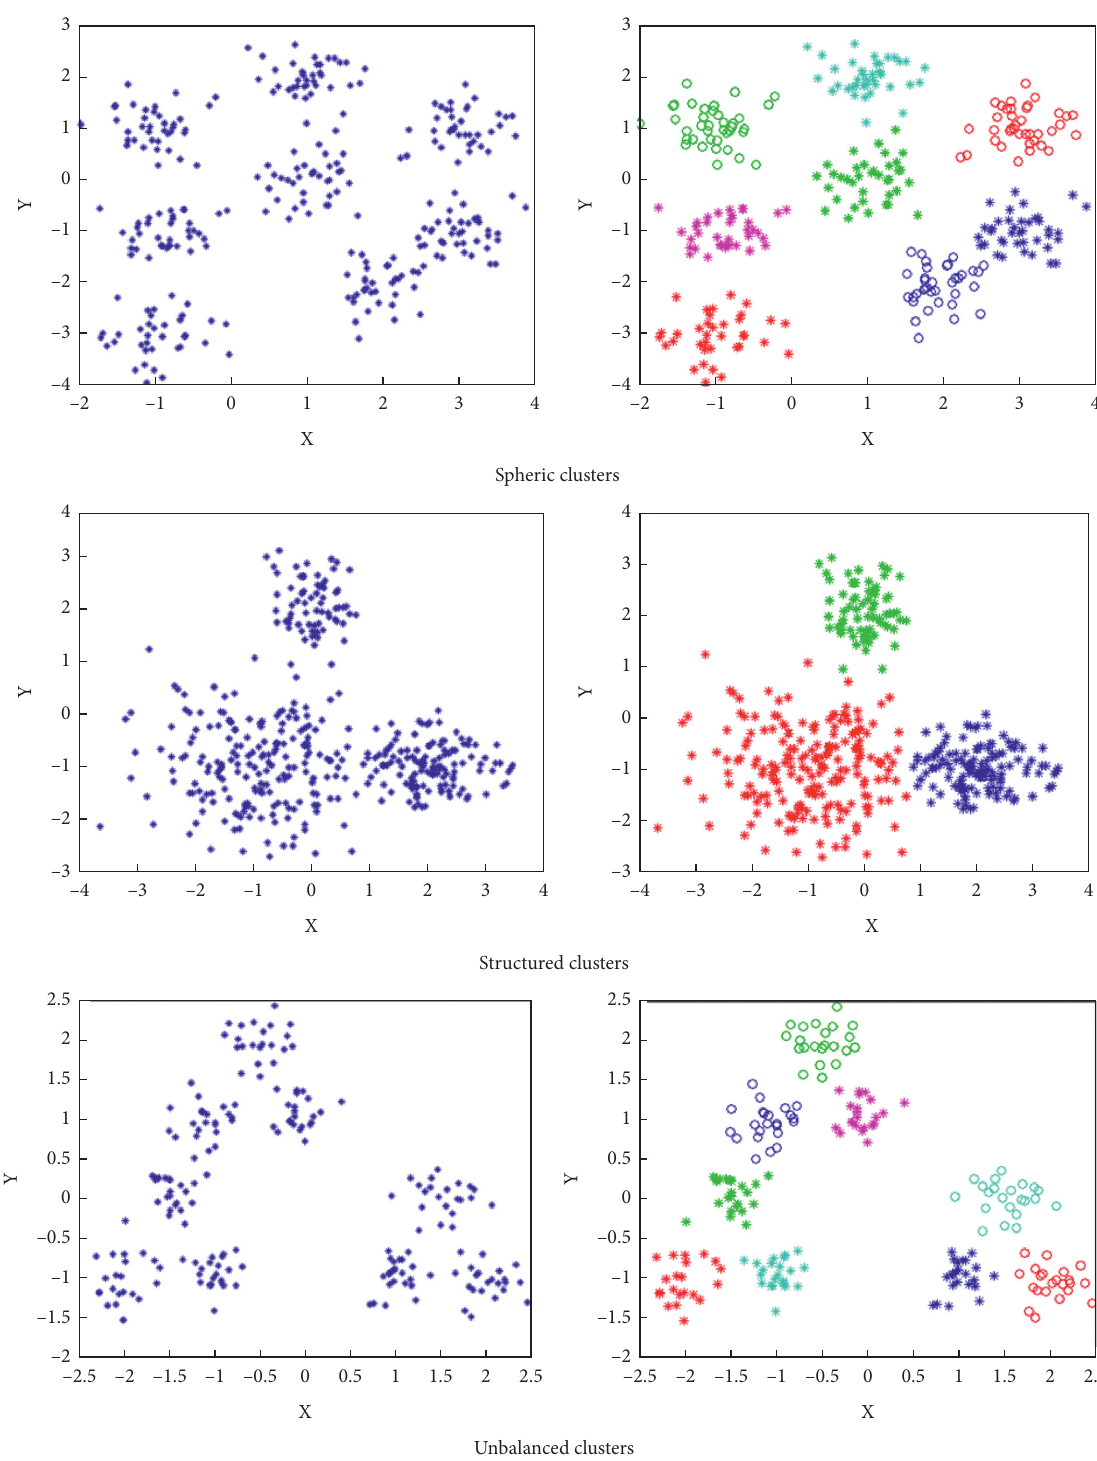
Figure 8: Different types of datasets as training